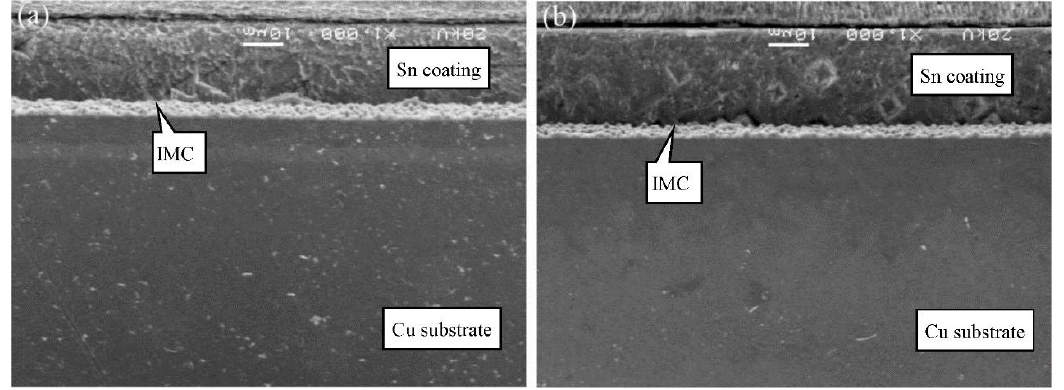
Figure 10. Cross-sectional microstructure of C11000 foils coated at 280 °C with different dipping time: ( a ) 2 s and ( b ) 4 s.